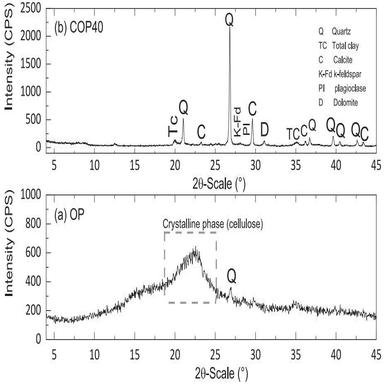
XRD patterns: (a) Olive pomace (b) composite COP40.